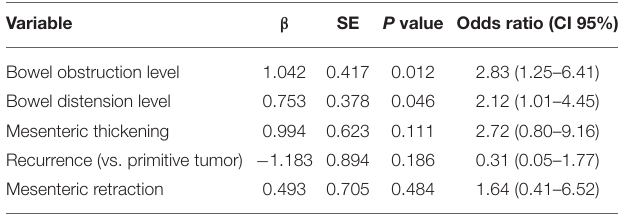
TABLE 5 | Multivariate analysis (logistic regression) of factor associated surgery failure.